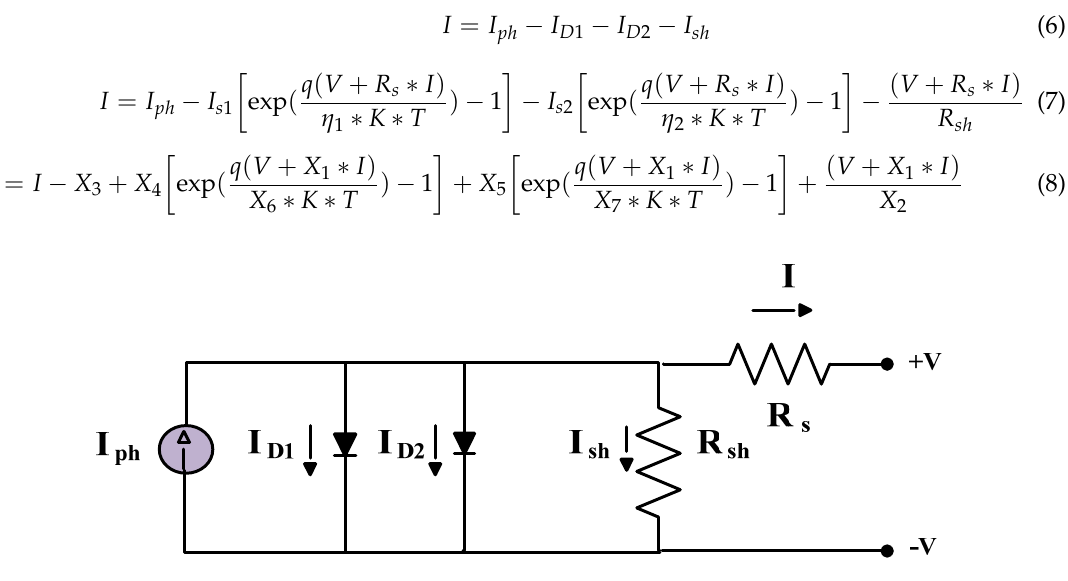
Figure 3. The DDM.